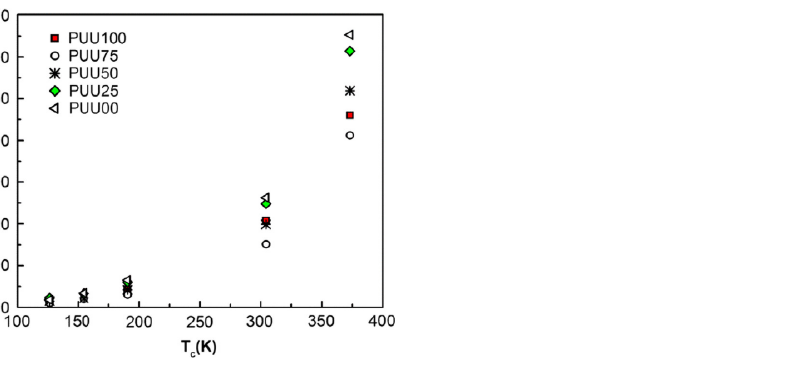
Figure 22. The relationship between solubility and critical temperature of the gases [48].